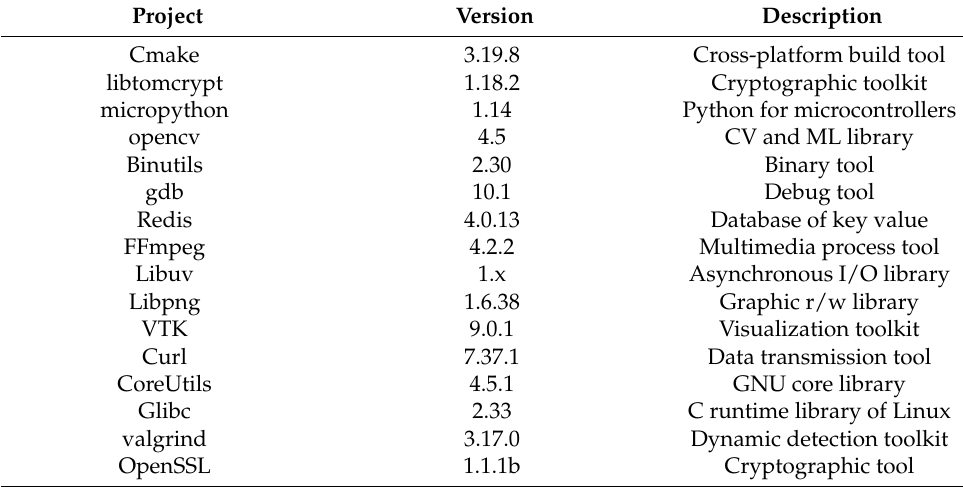
Table 3. Open-source projects used in the dataset.